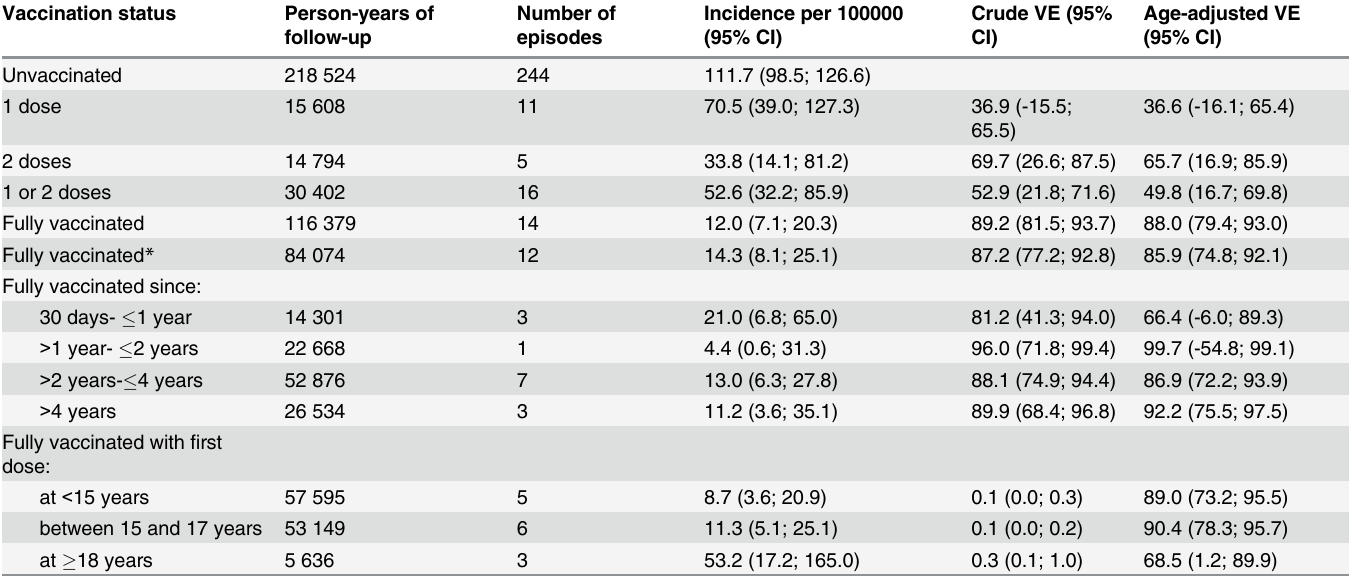
Table 4. Crude and age-adjusted vaccine effectiveness (VE) estimates for genital wart by number of qHPV vaccine doses, time since vaccination and age at first vaccine dose. Women eligible for HPV vaccination in Belgium and affiliated to the MLOZ sick